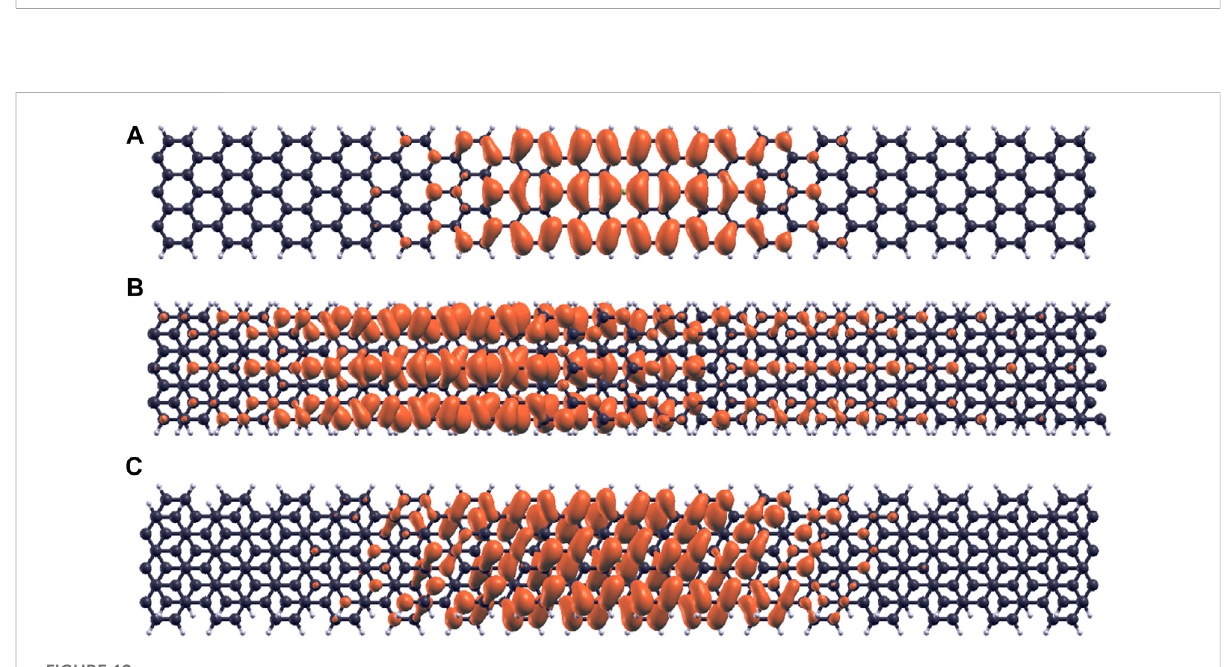
FIGURE 12 Comparisonof E 1,1 excitonwavefunctionsinsinglelayer,bilayer α andbilayer β 7-AGNR. (A) E 1,1 excitonwavefunctioninsinglelayer7-AGNR. (B)